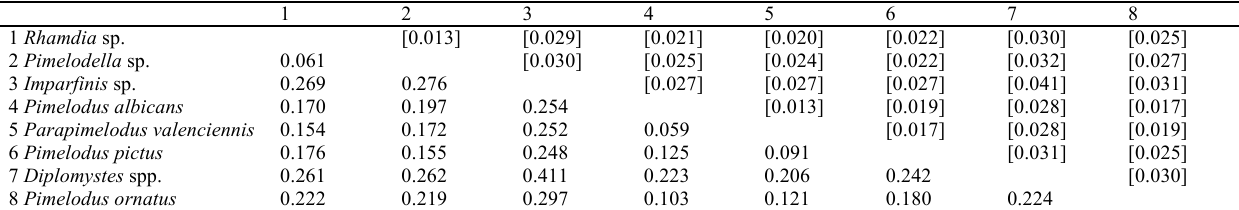
Table 2. Pairwise corrected genetic distances among Siluriformes taxa (below diagonal) and values of the corresponding standard error computed by bootstrap (500 replicates) (above diagonal).